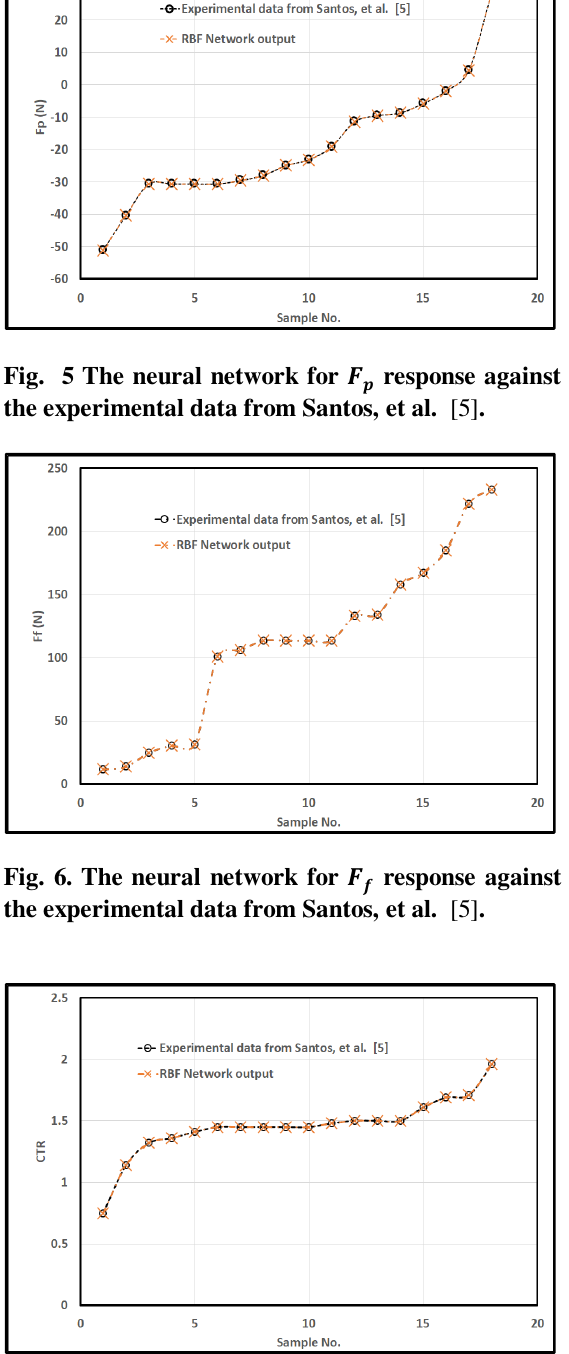
Fig. 10. surface when the cutting speed is (683 )+*